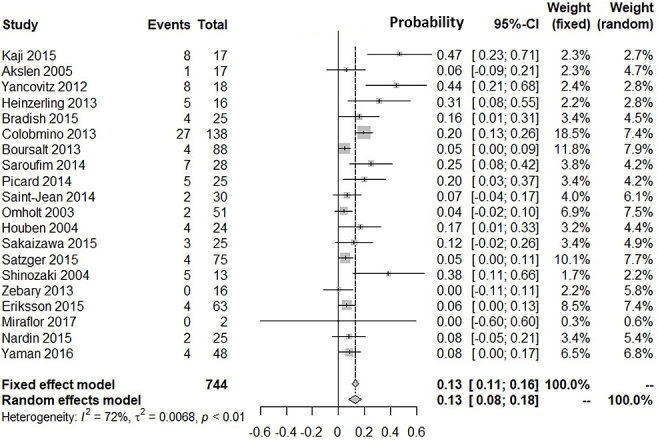
Proportion of disagreement for BRAFV600E mutations between primary and metastatic lesions.